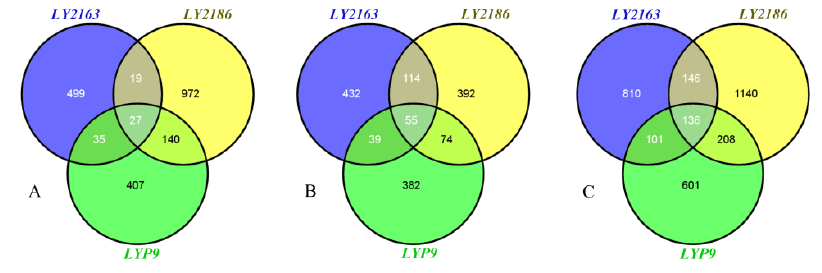
Figure 2. Venn diagram of differentially expressed genes (DGs) shared by three hybrid combinations. ( A ) DGs at the flowering (Fw) stage; ( B ) DGs at the filling (Fi) stage; ( C ) DGs at either the Fw or Fi stage.